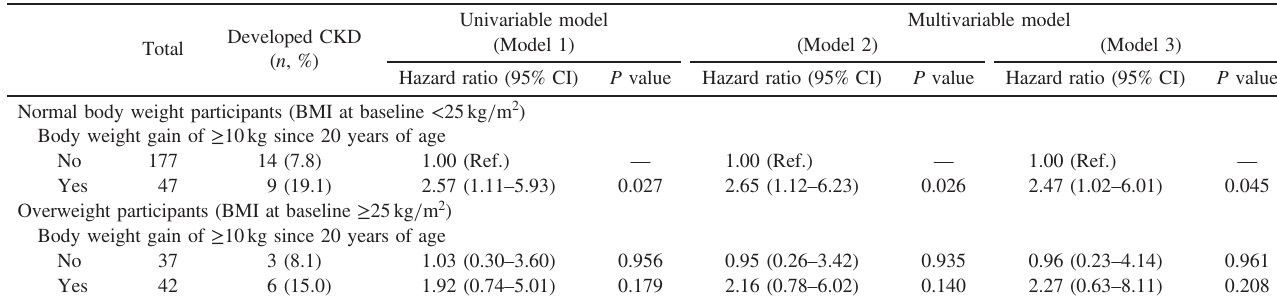
Figure 3. The cumulative incidence of CKD after 6 years follow-up period based on the combination of presence / absence of overweight participants with and without a body weight gain of ; 10kg since 20 years of age. CKD, chronic kidney disease. Table 3. The in fl uence of the combination of presence / absence of current body weight with and without the long-term body weight gain after maturity on the incidence of